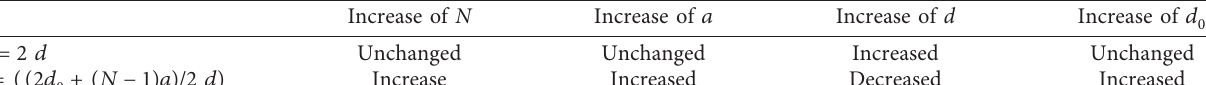
of Network II when N is even. 0